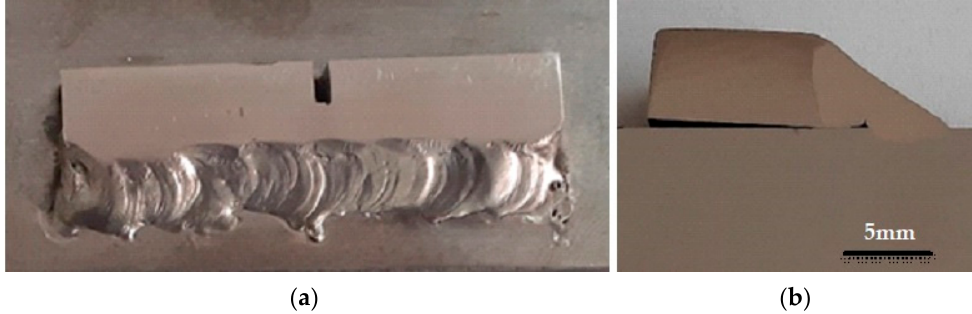
Figure 1. Aspect of the welded joint between HEA and S235JR substrate ( a ) and cross-sectional sample prepared for metallographic analysis ( b